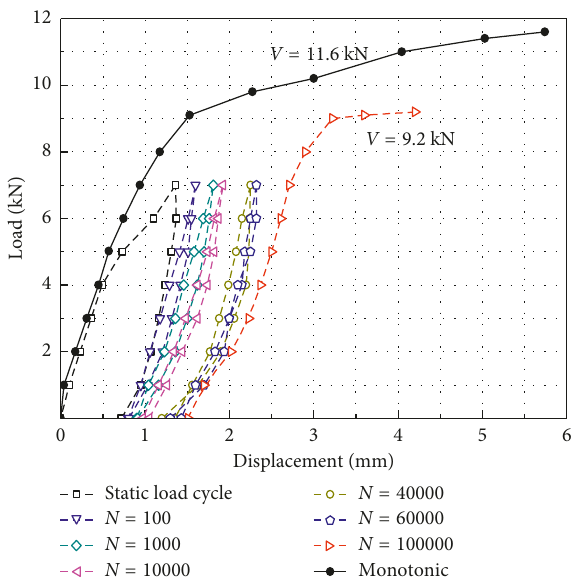
Figure 4: Load-displacement curves for specimen